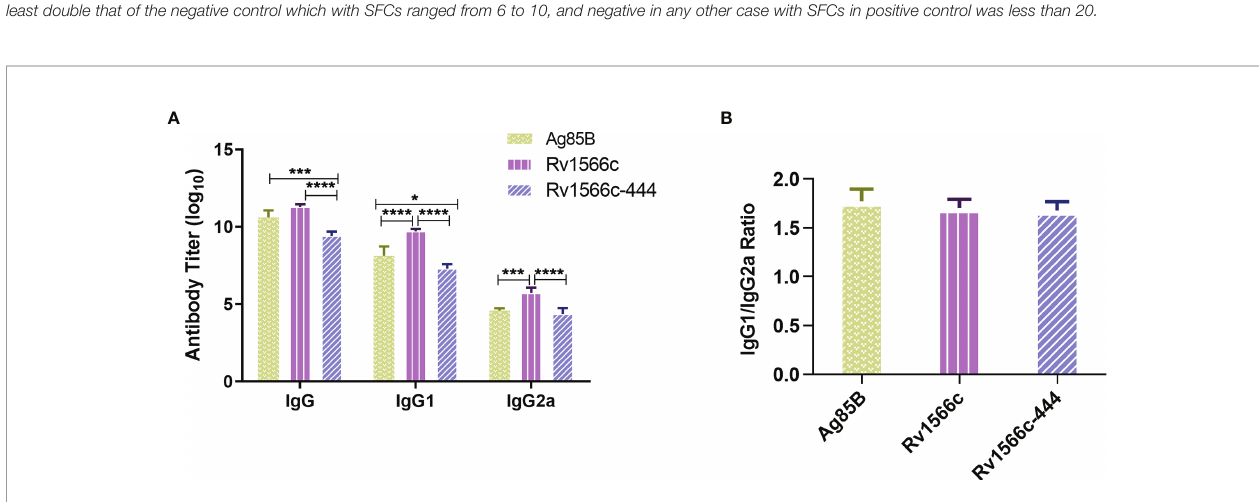
FIGURE 4 | Assays of IgG, IgG1, and IgG2a isotypes in sera of Rv1566c-444, Rv1566c, and Ag85B immunized BALB/c mice. (A) Antibody titers of total IgG, IgG1, and IgG2a were compared between the three groups. (B) Antigenic IgG1/IgG2a ratios were compared between the three groups. The P-values of the differences were determined by one-way ANOVA with Turkey ’ s multiple comparison tests (*P < 0.05, ***P < 0.001, ****P < 0.0001).